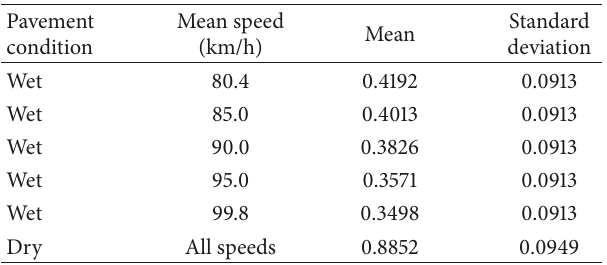
Table 2: Coefficients of friction